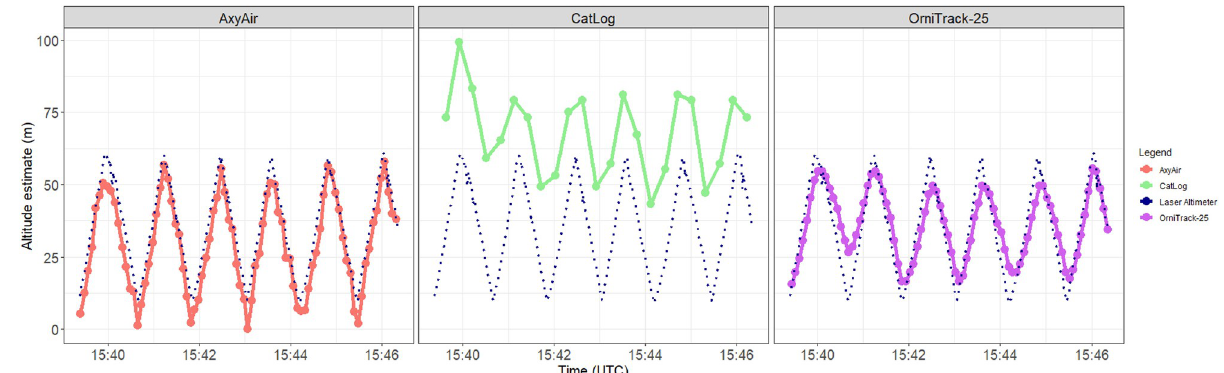
Fig 5. Example of vertical flight movements captured by the laser altimeter (dashed line) and the three different device types on a single flight (flight number F31). On half of the flights (n = 5) the CatLog did not display sinusoidal movements such as the one depicted in this figure, and therefore this represents anomalous movements by the CatLog device.